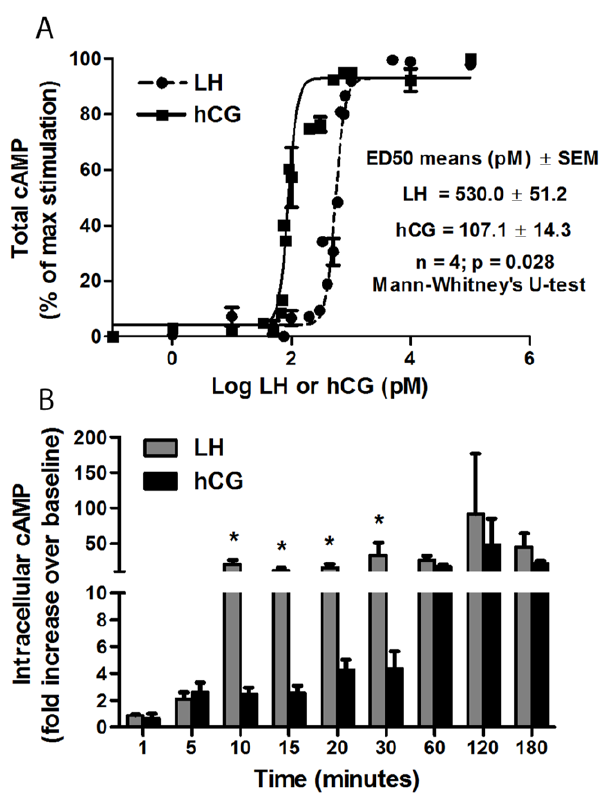
Figure 1. Dose-response and time-course experiments. a. Dose- response experiment to r-hLH and r-hCG in COS7/LHCGR in the presence of 500 m M IBMX. Total cAMP was measured after 3 hours of incubation and the results of four independent experiments were plotted (Mean 6 SEM). b. Time-course experiment performed by continuous incubation of COS7/LHCGR for different time-points in the presence of 500 m M IBMX and gonadotropins at ED 50 doses (500 pM r- hLH; 100 pM r-hCG). Intracellular cAMP was measured (n=3; Mean 6 SEM). Asterisk indicates the significant differences of hLH vs hCG ( t-test ; p ,